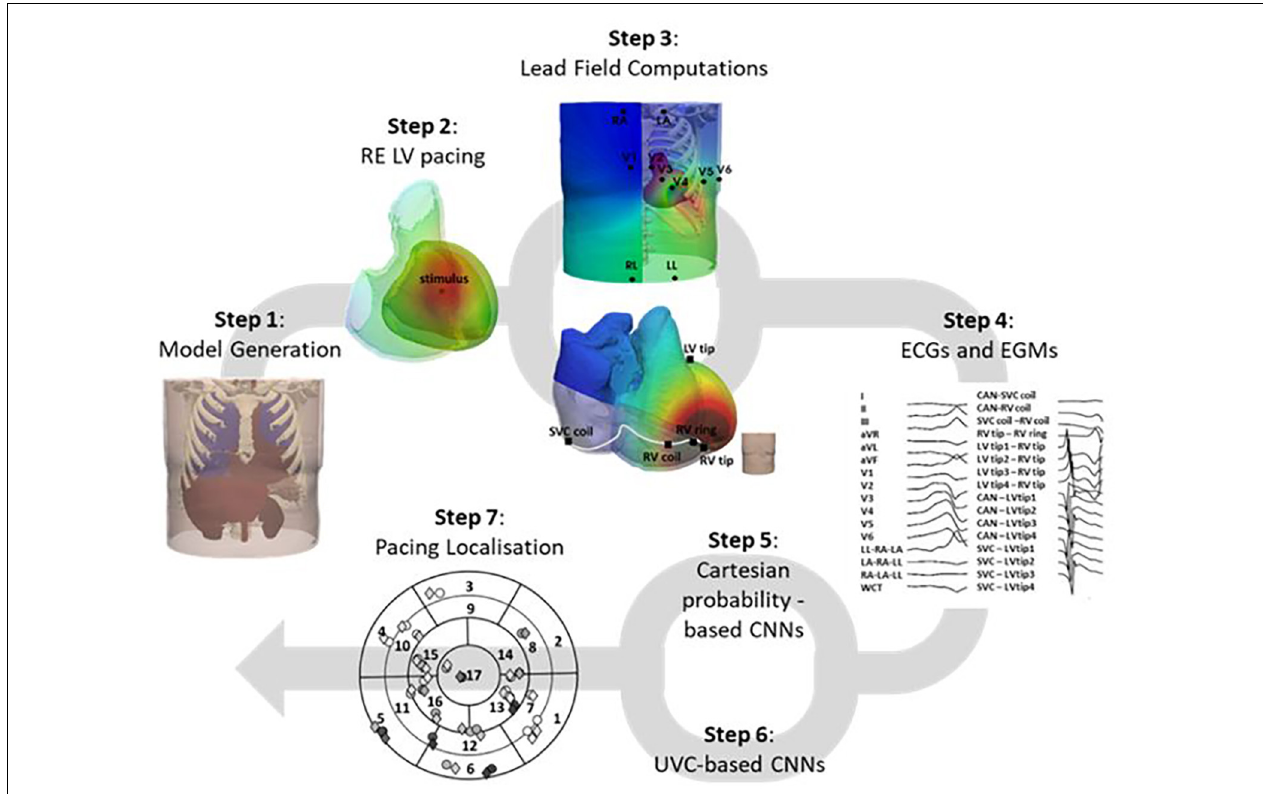
FIGURE 1 | Study workflow. The 3D torso model, generated (step 1) from a CT TAVI planning scan, was utilized to pace the LV from different locations, within a fast RE environment (step 2). These solutions were combined with LF matrices computed (step 3) on the 12-lead ECG electrodes and manufacture-guided CIED leads to generate accurate ECG and EGM traces (step 4), which were then used as inputs to two CNN architectures, one Cartesian probability-based (step 5), and one novel UVC-based (step 6). Localization of the paced beats across the LV was then computed (step 7) and compared to the actual locations of the simulated beats.